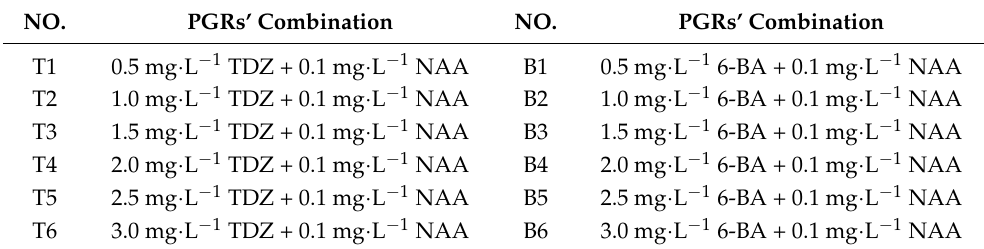
Table 1. Composition of mediums used to establish regeneration system.